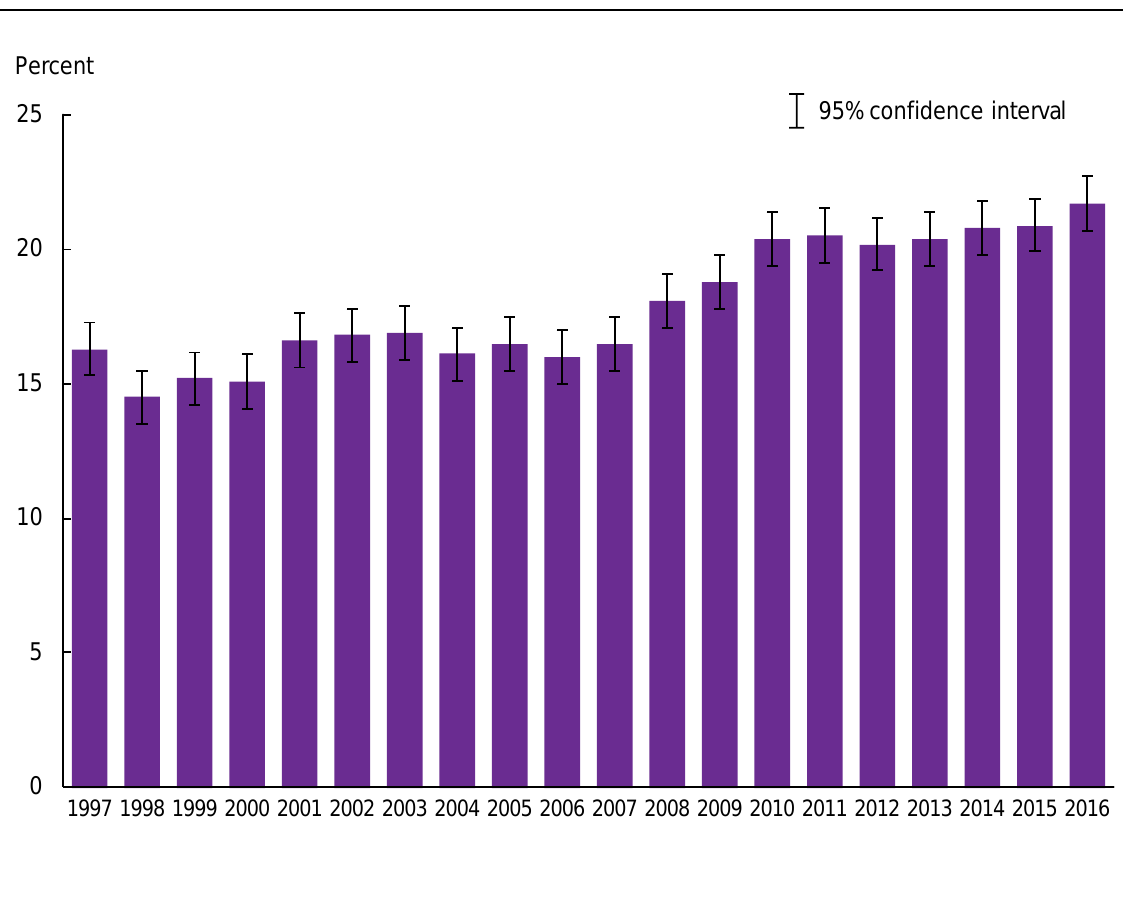
Figure 7.4. Percentage of adults aged 18 and over who met 2008 federal